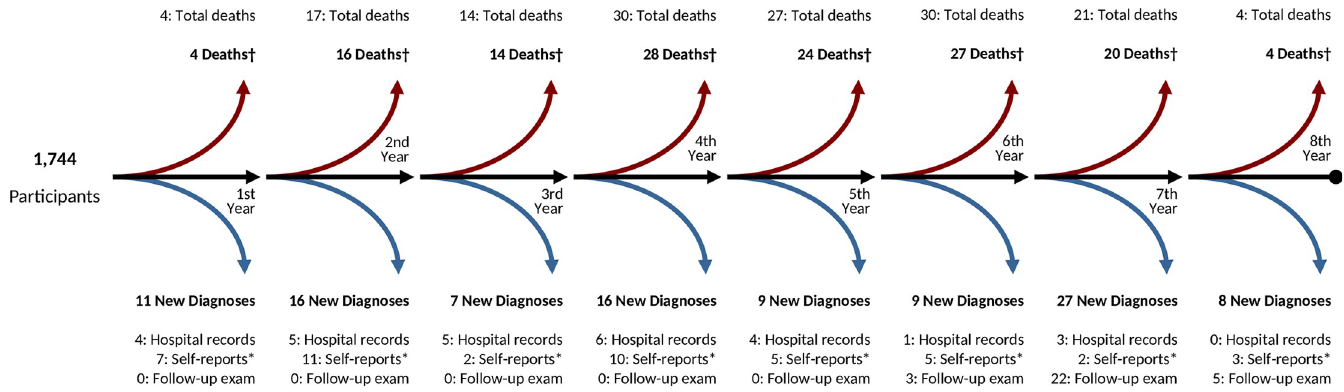
Fig 1. Flow diagram of participants and the timing of T2D diagnoses. � Self-reported physician-diagnosed T2D. † Decedents without T2D at the time of death. FPG, fasting plasma glucose; T2D, type 2 diabetes.